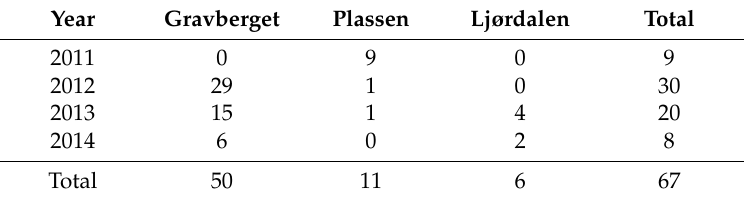
Table 1. Distribution of number of stands per study site and year of scarification. Year Gravberget Plassen